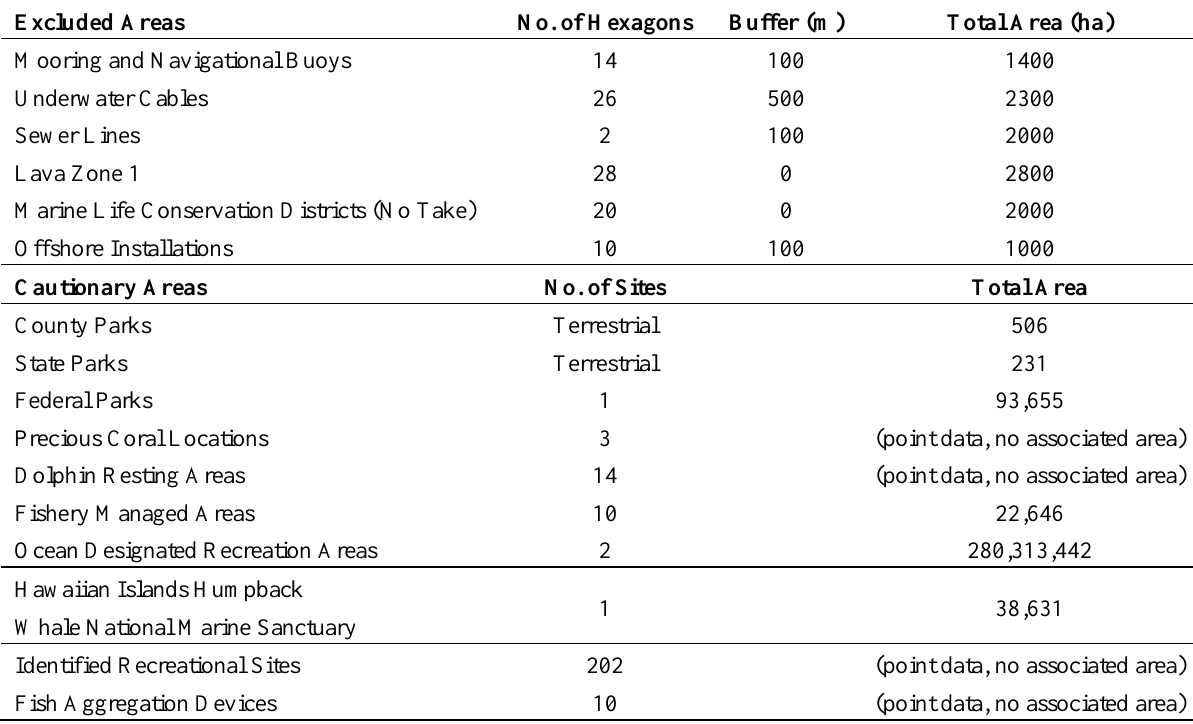
Table 3. List of parameters excluded or labeled as cautionary from all nearshore aquaculture models including buffer distances and total